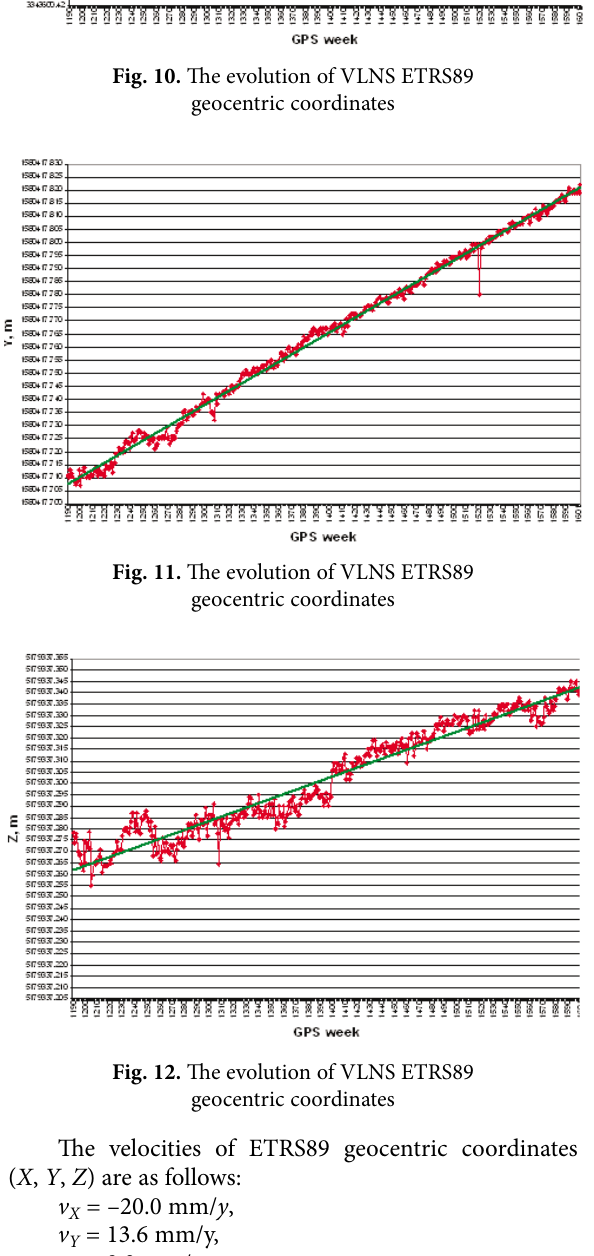
Fig. 12. The evolution of VLNS ETRS89 geocentric